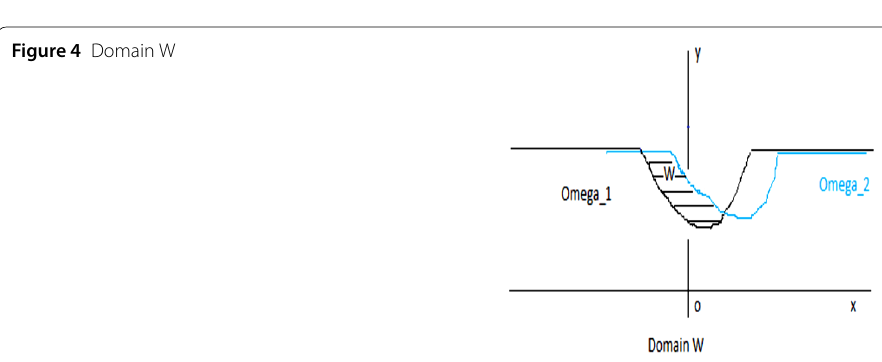
Figure 4 Domain